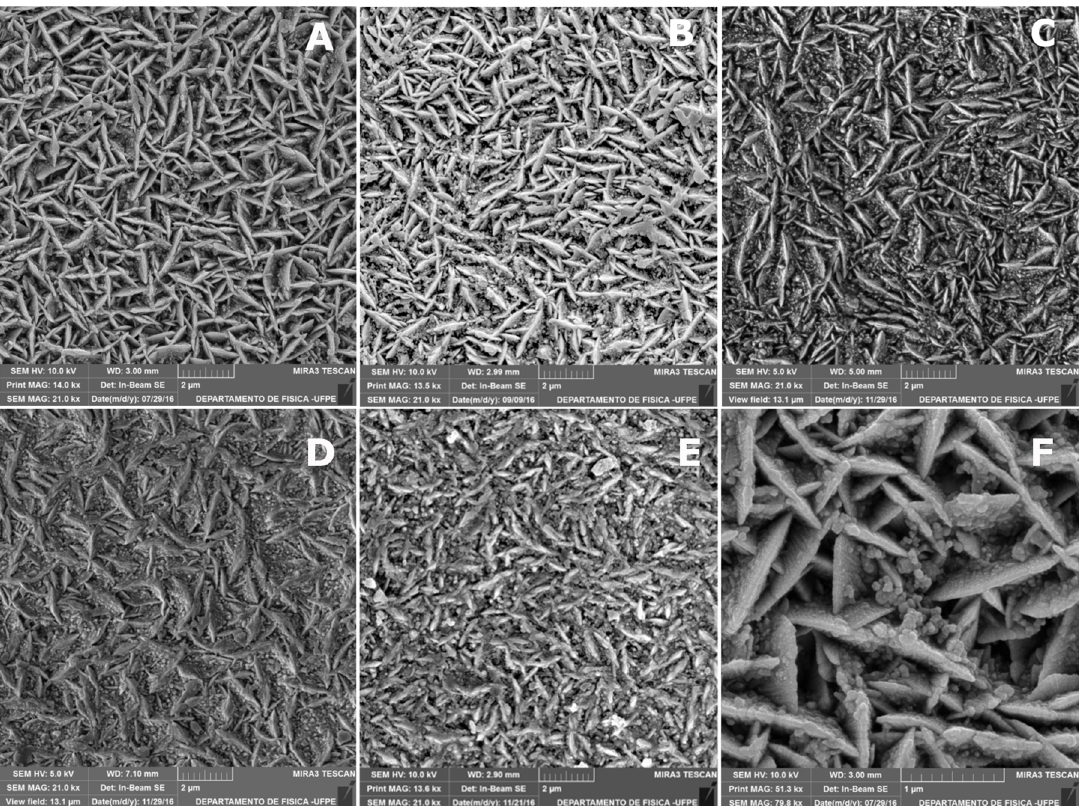
Figure 2. SEM morphology of Co-Ni/SiC coatings prepared at galvanostatic deposition of density currents: (A) 2 A dm -2 ; (B) 3 A dm -2 ; (C) 4 A dm -2 ; (D) 5 A dm -2 ; (E) 6 A dm -2 . (F) SiC nanoparticles deposited in the coating 2 A dm -2 .